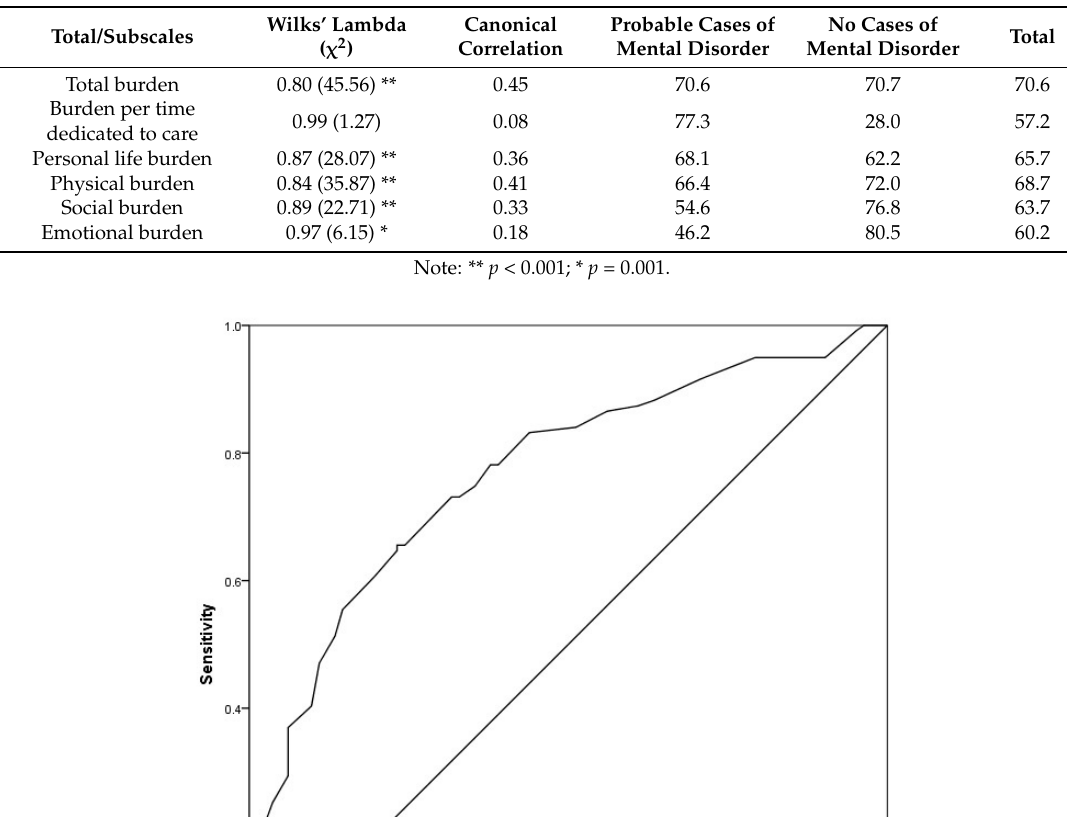
Table 6. Discriminant analysis and percentage of cases correctly classified of the 15-item CBI.